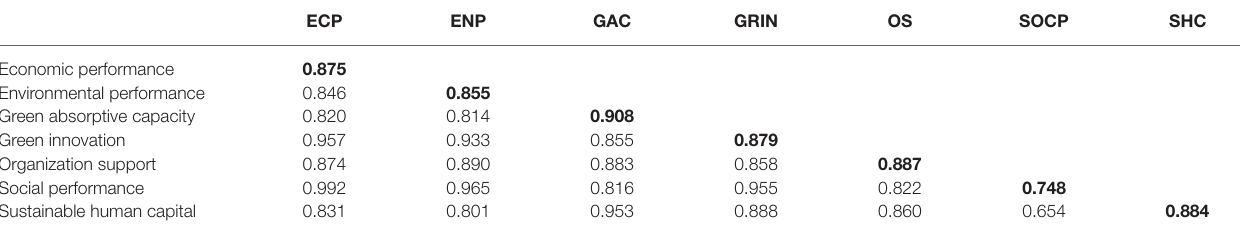
TABLE 3 | Co-relation matrix. ECP ENP